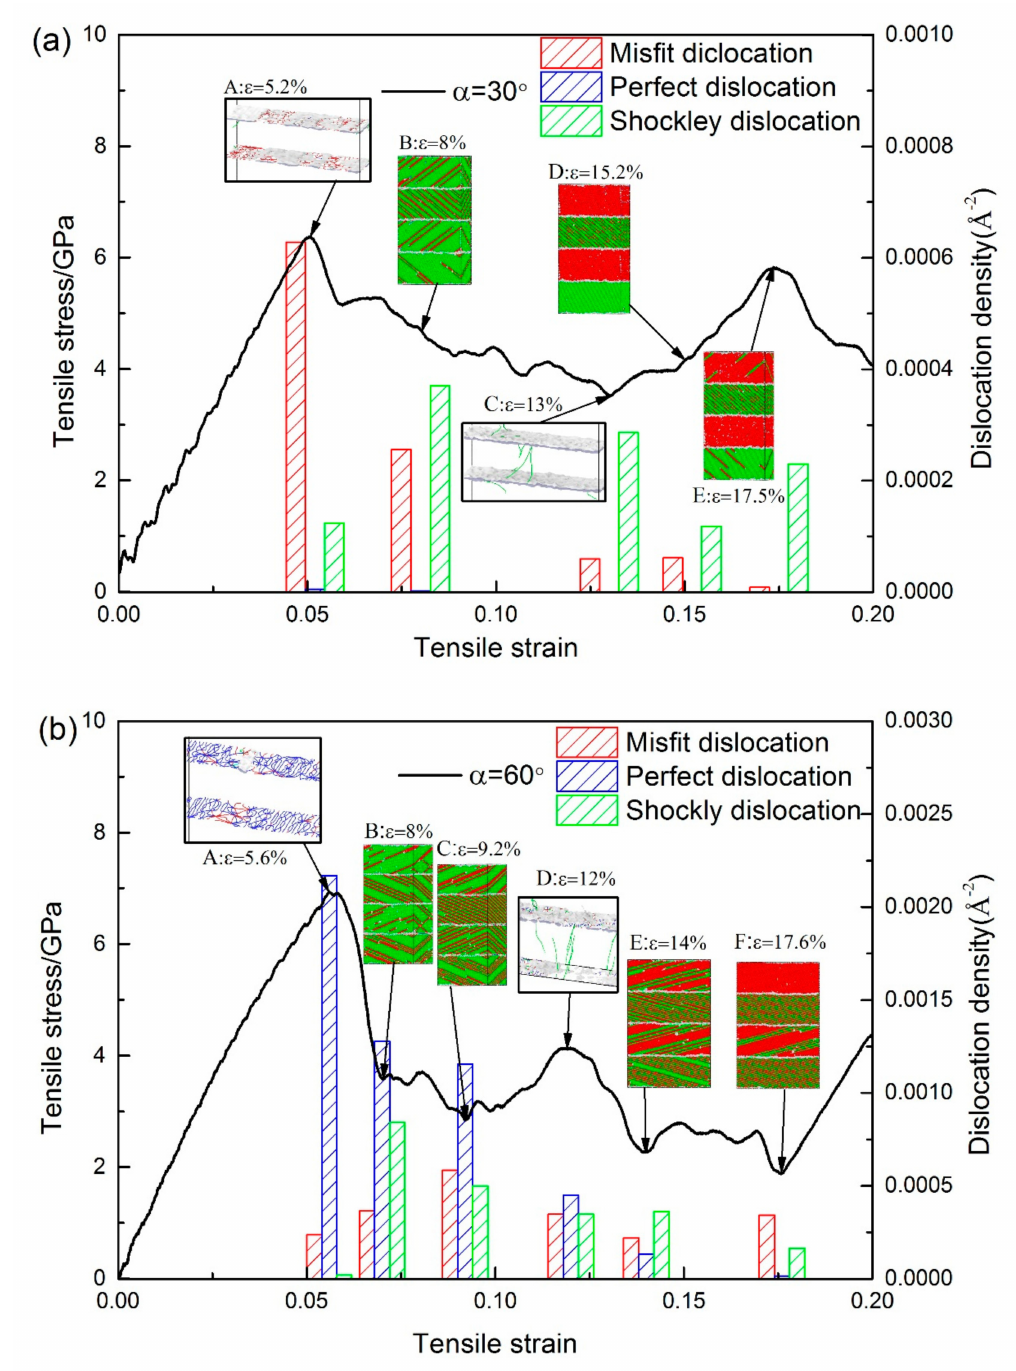
Figure 5. ( a ) Plots for both the stress-strain curve and dislocation density for the models with α = 30 ◦ . Snapshots A and C: DXA at ε = 5.2% and 13%, respectively. Snapshots B, D, and E: CNA at ε = 8%, 15.2%, and 17.5%, respectively. ( b ) The plots for both the stress-strain curve and dislocation density for the models while α = 60 ◦ . Snapshots A and D: DXA at ε = 5.6% and 12%, respectively. Snapshots B, C, E, and F: CNA at ε = 8%, 9.2%, 14%, and 17.6%,